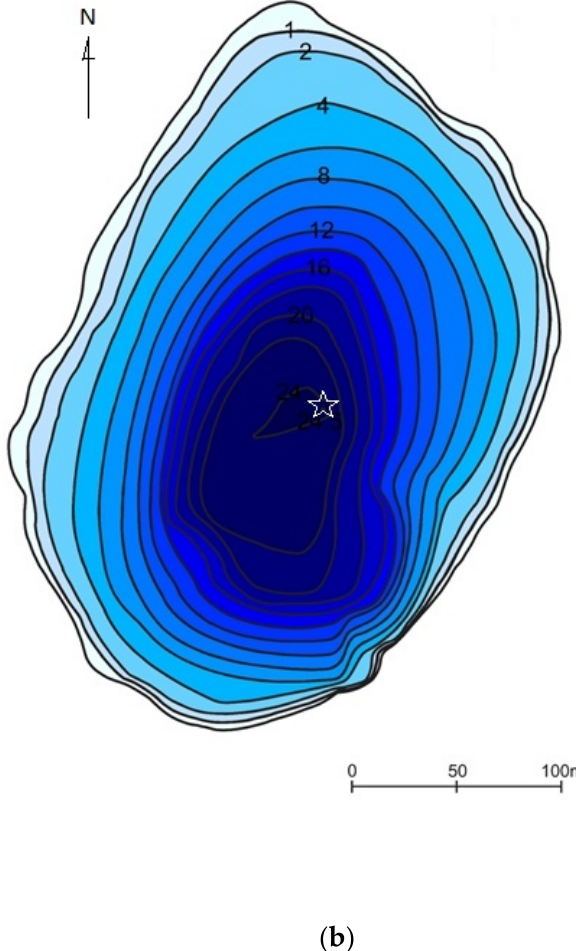
Figure 1. Starodworskie Lake and its surroundings (watershed line is marked as a yellow line). ( a ) Location of sampling station (source: [25], modified); ( b ) bathymetric map of Starodworskie Lake (after [4], modified). * sampling station coordinates: 53.7475905 N 20.45347389 E (WGS84). Table 1. Basic morphometrical parameters of Starodworskie Lake [4].